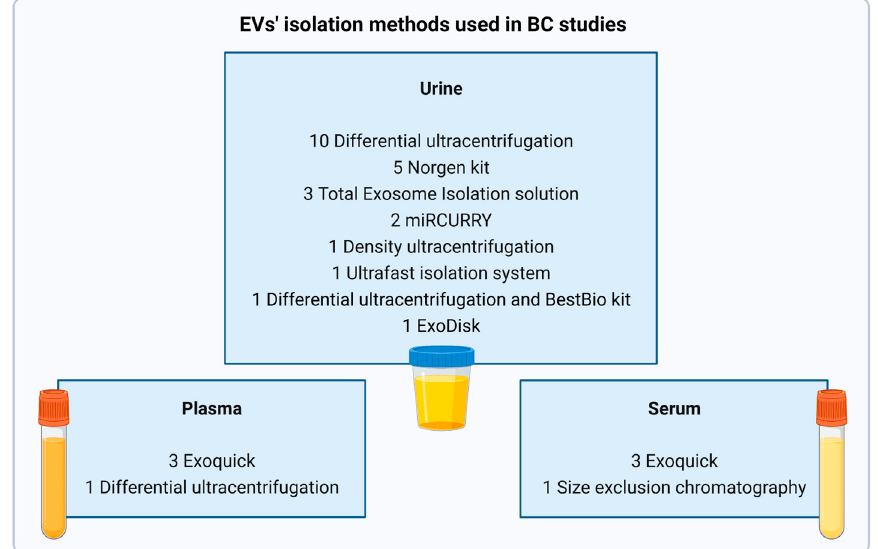
Figure 3. Summary of extracellular vesicle isolation methods that were used in BC articles, concerning urine, plasma, and serum. Numbers represent the number of BC-EV biomarker studies. Abbreviations: BC—Bladder cancer; EVs—extracellular vesicles. Created with BioRender.com.